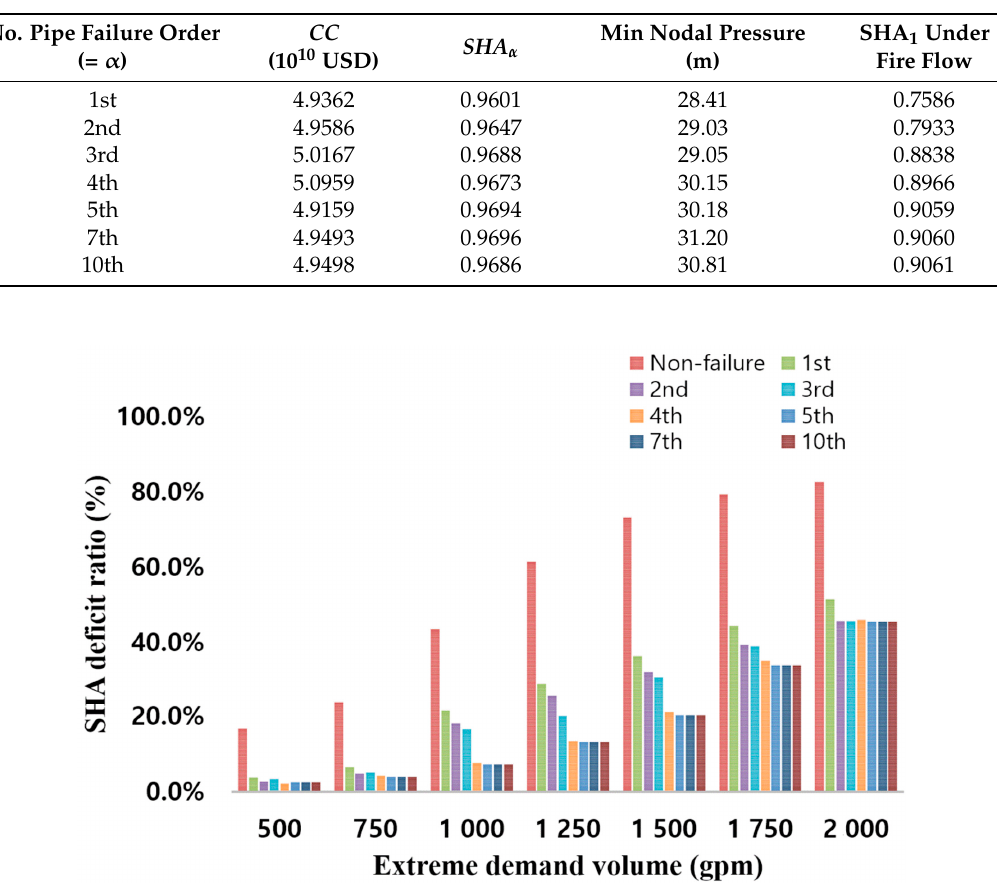
Table 4. Mechanical redundancy ( SHA α ) values for different orders of pipe failure.